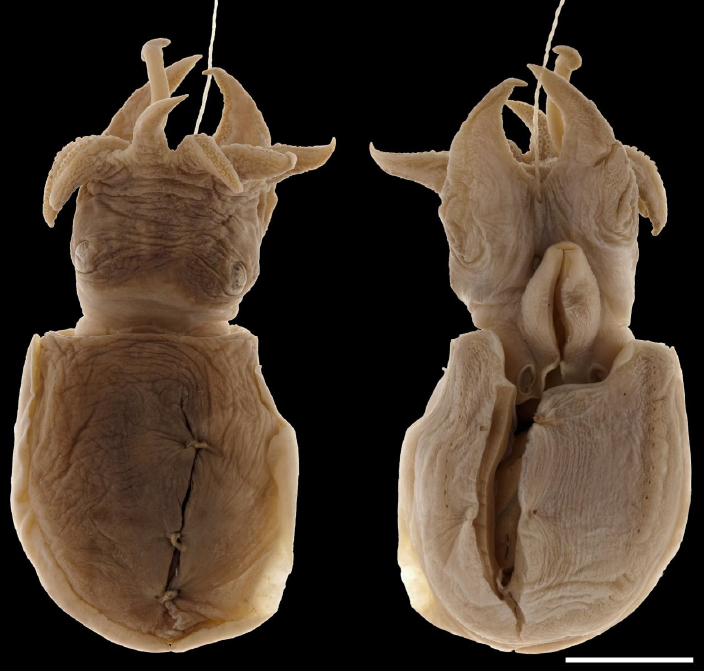
Figure A1. Sepia typica (Steenstrup, 1875) holotype (NHMD-77360, female ML 26, 6gm, Zoological Museum, Copenhagen), dorsal ( left ) and ventral ( right ) aspects. Scale bar 10 mm.